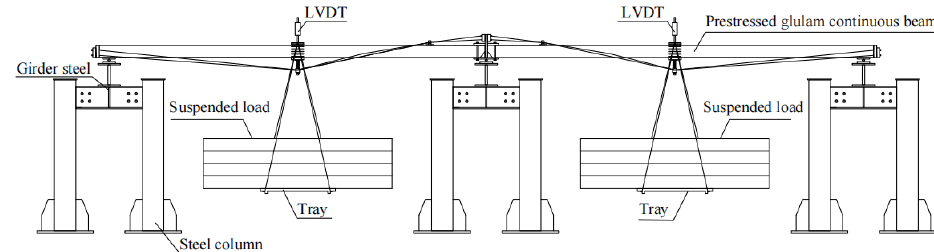
Figure 5. Long-term loading schematic.